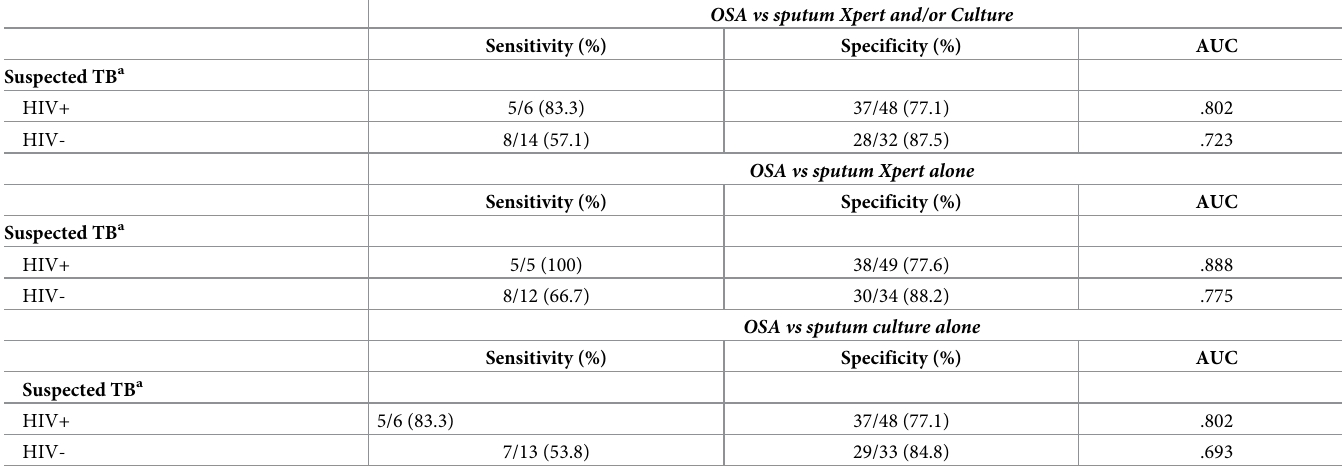
Table 3. OSA diagnostic performance by HIV